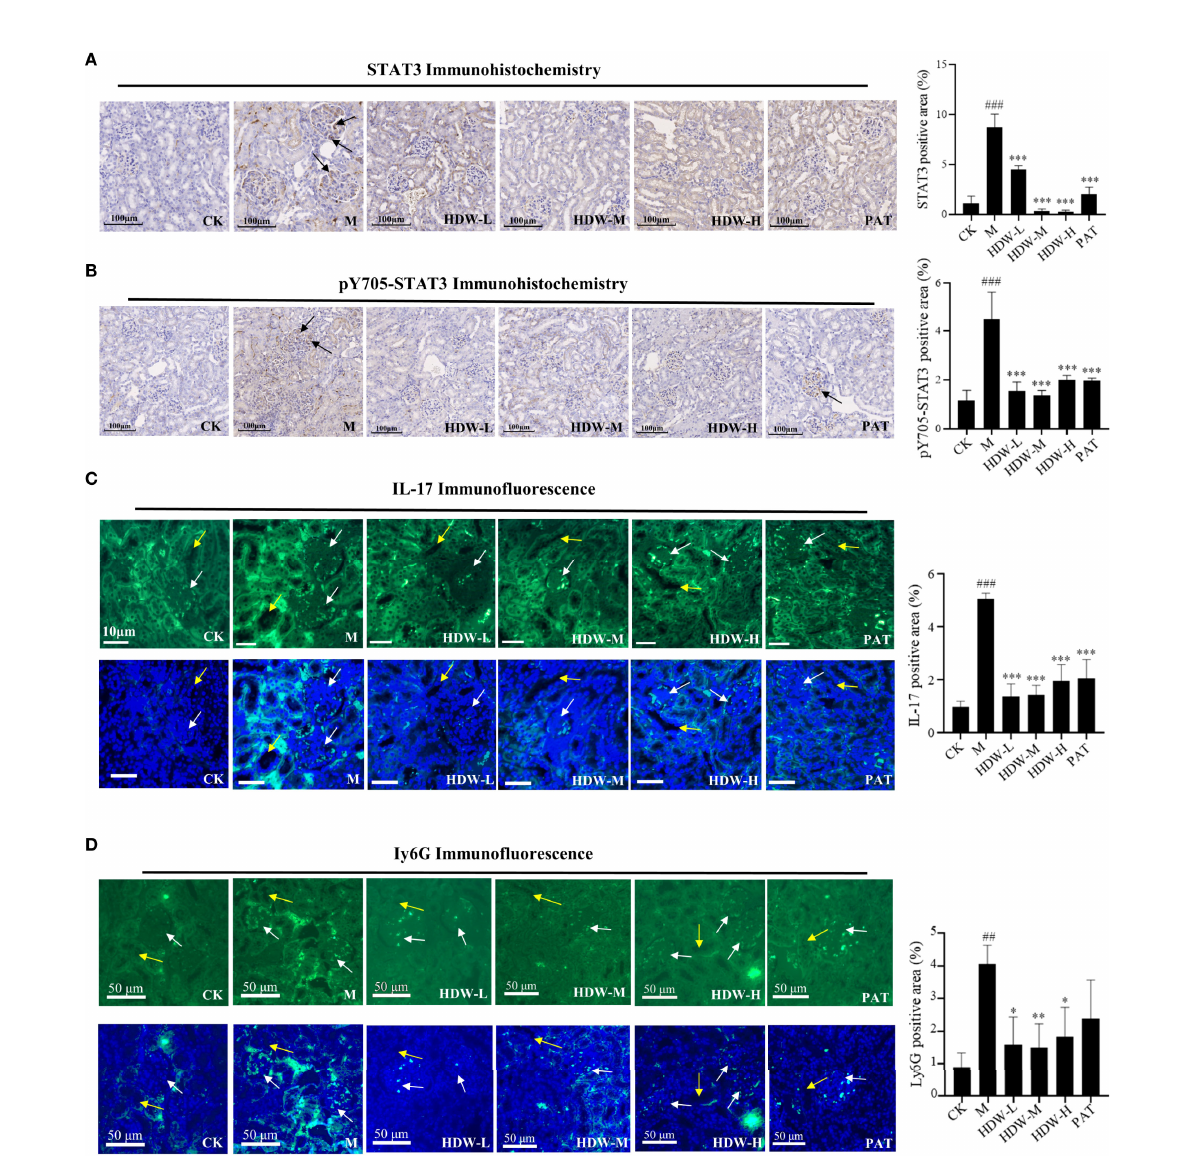
FIGURE 4 Effect of HDW on the expression of STAT3, IL-17, and Ly6G in the kidney of MRL/lpr mice. (A) STAT3 immunohistochemistry staining. (B) pY705- STAT3 immunohistochemistry staining. Representative immunohistochemistry of STAT3 or pY705-STAT3 staining exhibited brown staining. The brown signals indicated by the black arrow are in the glomerular region. (C) Immuno fl uorescent staining of IL-17 (D) Immuno fl uorescent staining of Ly6G. White arrows indicate the glomerular region, and the yellow arrows indicate the tubular region. The right histogram shows the relative expression of STAT3, pY705-STAT3, IL-17, and Ly6G respectively. The expressions were quanti fi ed by pixel counting in three regions of each section. #Indicates the difference between the model group and the control group ## P < 0.01, ### P < 0.001; * Indicates the difference between the treatment group and the model group * P < 0.05, ** P < 0.01, *** P <